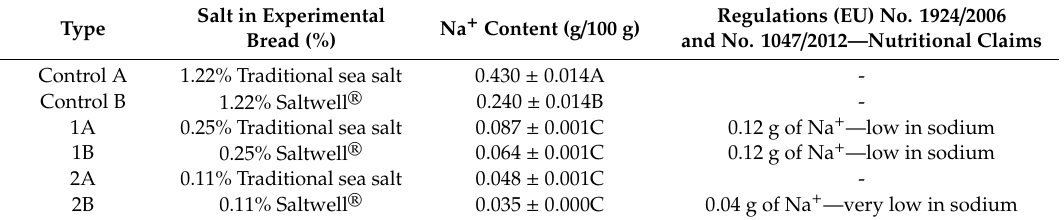
Table 3. Percentage of two salts in bread, sodium content and limits established by EU regulations [21,22] (data are means ± standard